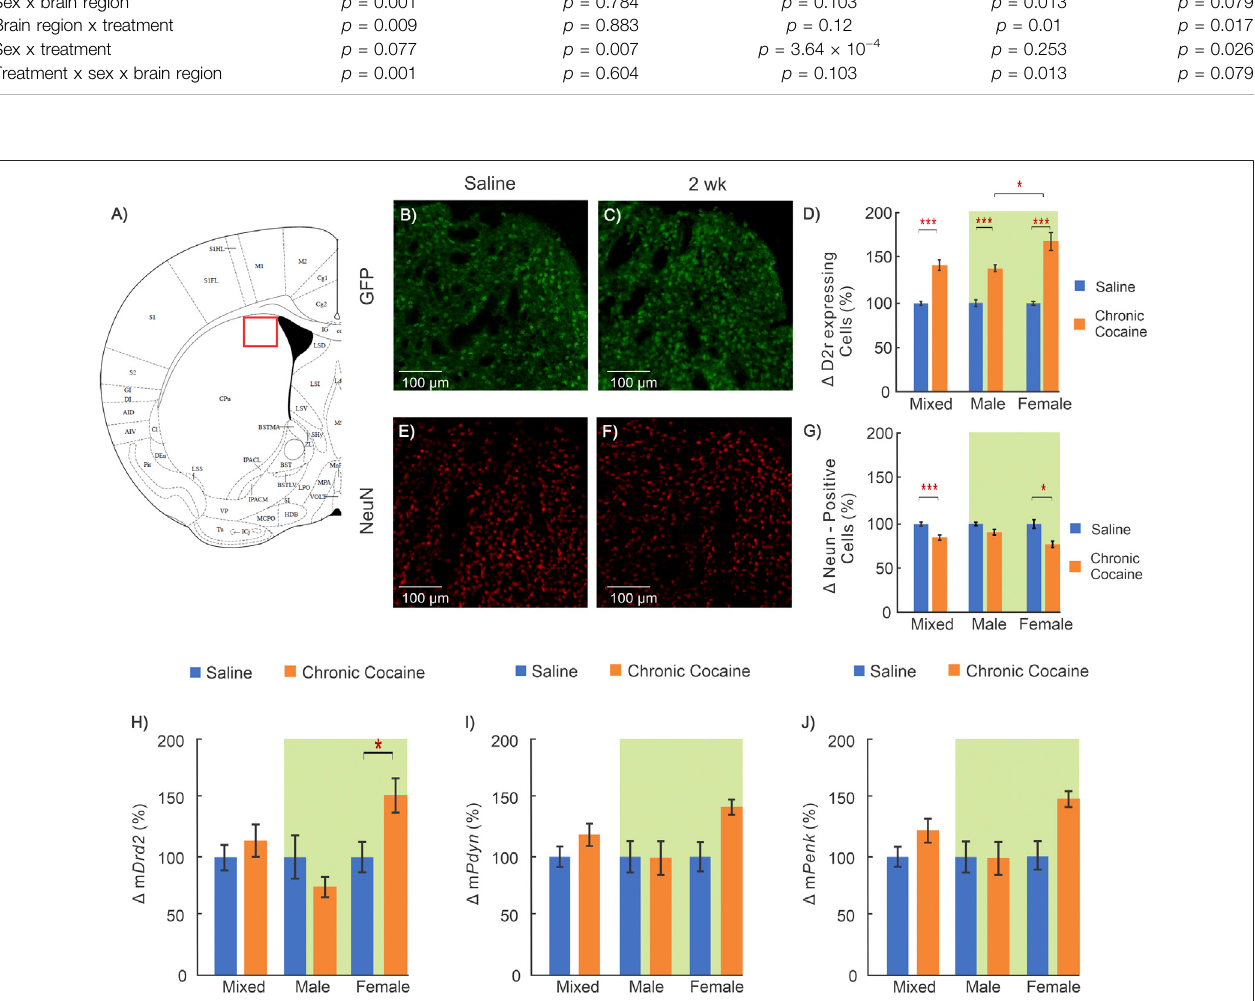
FIGURE 3| Cocaine effects in dorsal striatum (Dstr). (A) : Mouse brain atlas shows location where images were obtained for Dstr (George and Franklin, 2001) ; (B-C) : “ Zoom-in ” GFP images of a control and a cocaine exposed animal; (D) : Comparison of D2r-GFP expressing neurons in Dstr between saline (n (cid:2) 12; 5 \ , 7 _ ) and chronic cocaine (n (cid:2) 11; 5 \ , 6 _ ) exposed animals (2 weeks); (E-F) : Corresponding NeuN images of a saline treated and a cocaine exposed mouse; (G) : Comparison ofneuronsbetween controls(n (cid:2) 11; 5 \ , 6 _ )and cocaine(n (cid:2) 10;6 \ ,4 _ )exposed animals; (H-J) :Comparison ofmRNA levelsbetween control (n (cid:2) 12;6 \ ,6 _ )andcocaine(n (cid:2) 14;7 \ ,7 _ )animalsfor Drd2 (H) ,for Pdyn (I) and Penk (J) .Mixed:malesandfemales;female:femalesonly;male:malesonly;*: p < 0.05; **: p < 0.005; ***: p < 0.001. Blue bars correspond to saline and orange to cocaine treated mice. Data for two-way ANOVA highlighted in green. Values show averages and